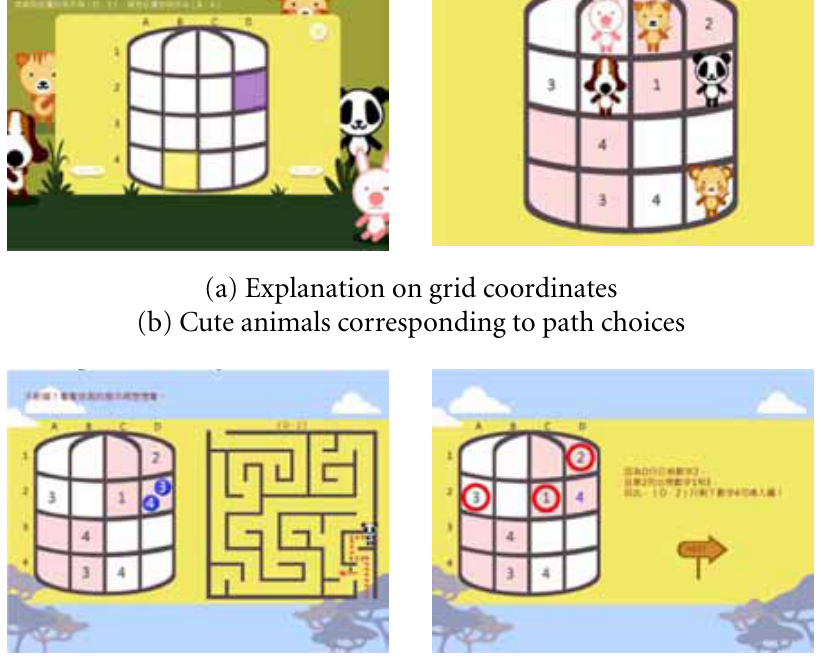
(c) Forking paths of labyrinth corresponding to Sudoku grid layout (d) Explanation on concept of specific answer (number) in the